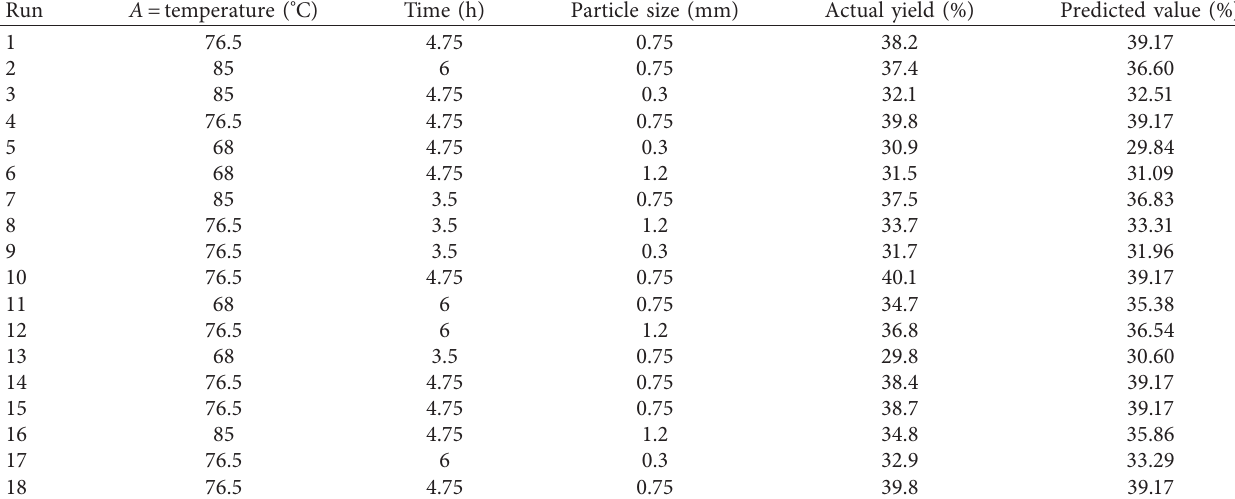
Table 2: Box–Behnken design of parameters and the response actual and predicted values.